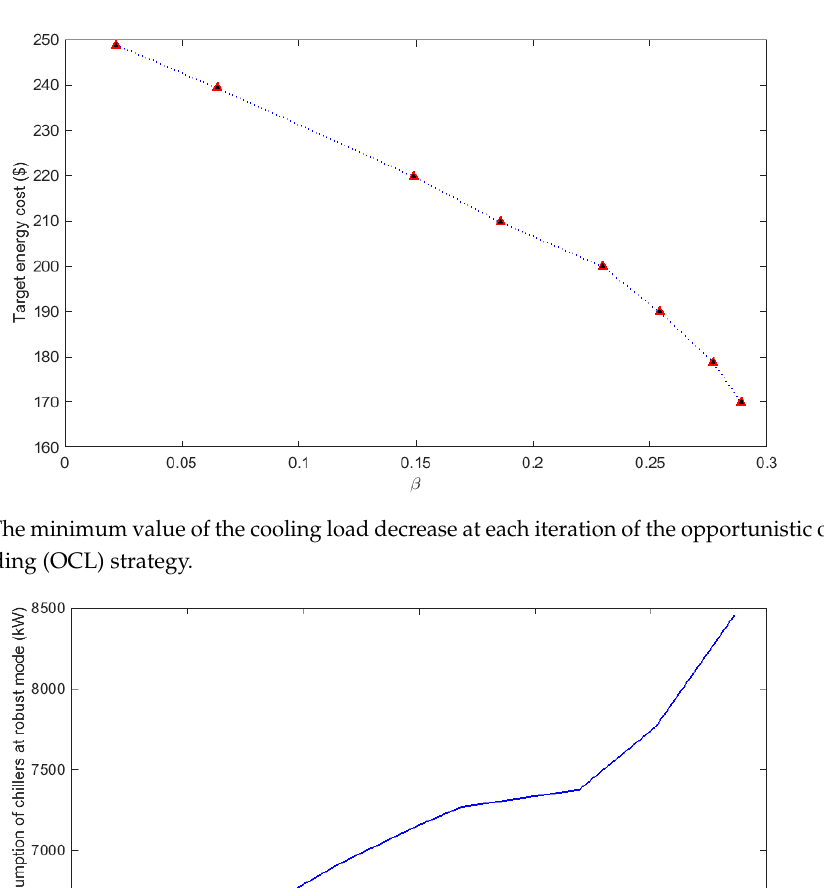
Figure 4. The optimum value of the cooling load increase at each scenario of the robust economic dispatch problem.